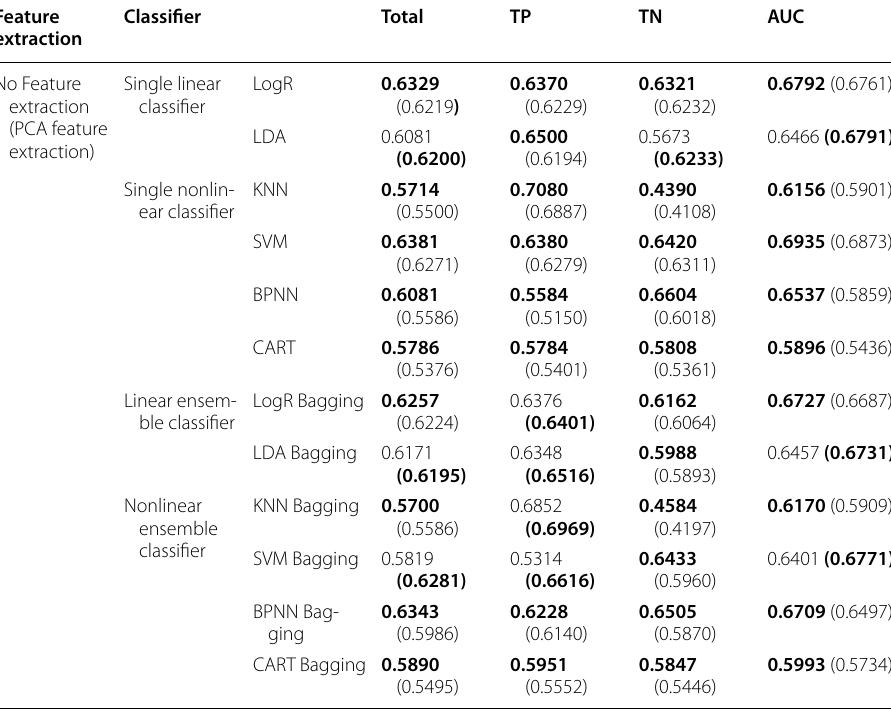
Table 5 Results of different classifiers without/with PCA in Kaggle dataset when feature dimensions sample size ≥